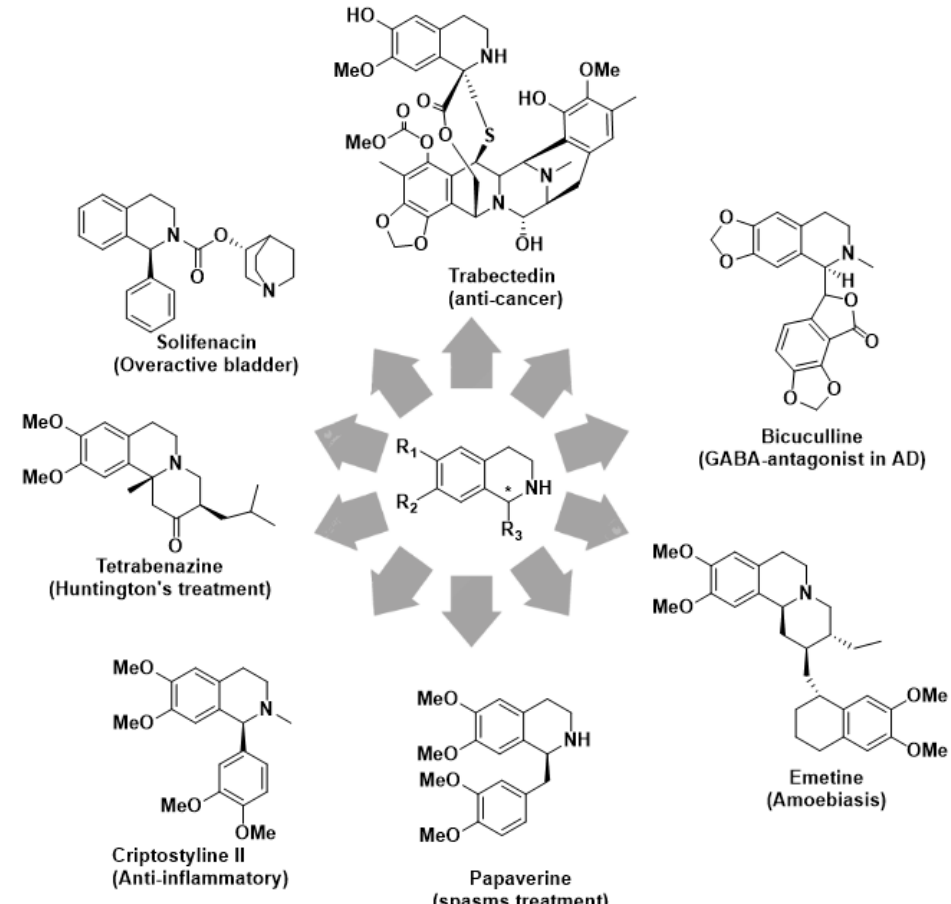
Figure 1. Tetrahydroisoquinoline core in biologically relevant natural and non-natural alkaloids.